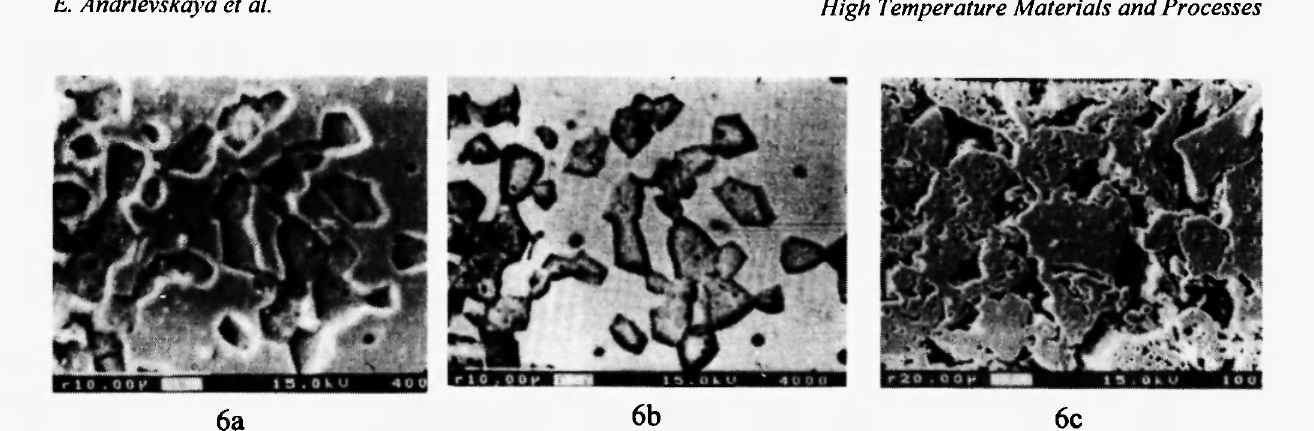
Fig. 6. Microstructures of the samples and element distribution through the samples in the definite field of compositions of the sub-system Sm 2 03-Sm2Hf 2 0 7 -Y 2 03 heat-treated at 1600 °C: (a) <B>+<C>+<F>, light is <F>, gray is <C-Y 2 0 3 >, dark is <B-Sm 2 0 3 >, 10 mol% Hf0 2 -10 mol% Y 2 O 3 -80 mol% Sm 2 0 3 ; (b) <B>+<C>+<F>, light is <F>, gray is <C-Y 2 0 3 >, dark is <B-Sm 2 0 3 >, 10 mol% HfO 2 -10 mol% Y 2 0 3 -80 mol% Sm 2 0 3 ; (c) Py+<C>, light is <F>, gray is <C-Y 2 0 3 >, dark is <B-Sm 2 0 3 >, 45 mol% Hfö 2 -25 mol% Y 2 0 3 -30 mol% Sm 2 0 3 .